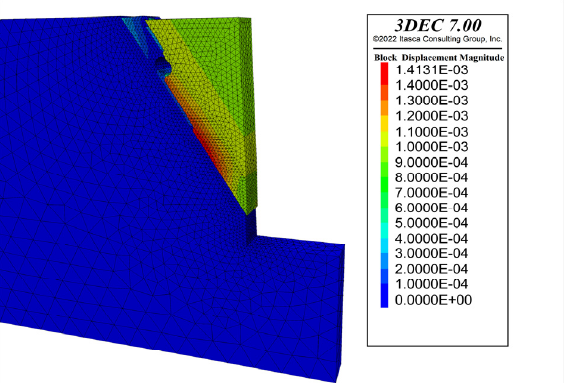
Figure 4. Pile diameter of 0.8 m, 1.5 times pile spacing, cantilever pile support (three retaining piles).